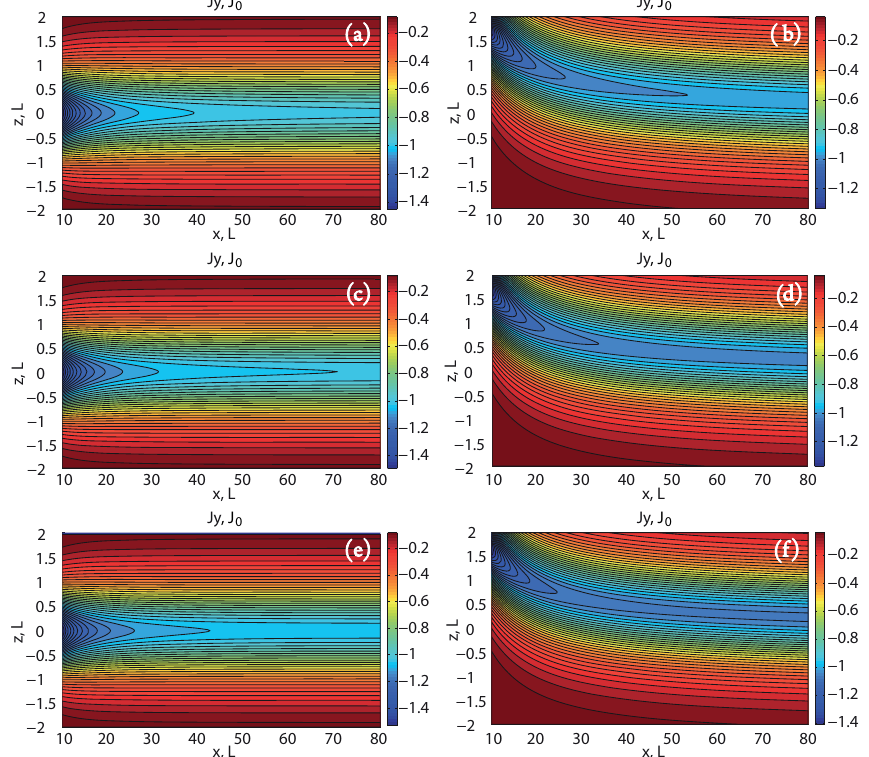
Figure 8. Current density J y (x,z) by an analytical model (Eqs. 11–16) for { a 1 = 0 , a 2 = − 0 . 03 , b = 22 . 13 , f = 0 , k = 1 } is shown for three values of the parameter n for plane sheets ( a , c , e , ϕ = 0) and curved sheets ( b , d , f , ϕ = 60). In panels (a, b) , n = 0 . 995. In (c, d) n = 1. In (e, f) , n = 1 . 005. Panel (c) corresponds to the plane substorm sheet (see Fig. 4c). Units are normalized for CS typical width L and J 0 = cB 0 /( 4 πL)